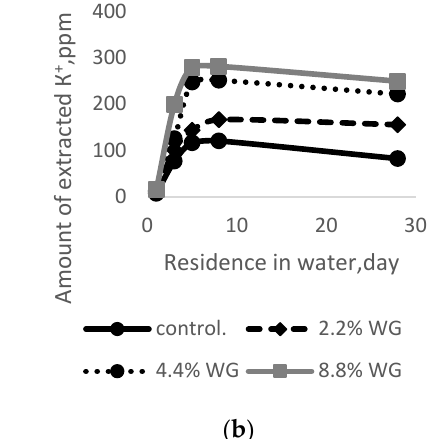
Figure 3. Dependence of the amount of extracted alkali cations on the addition of potassium WG and time in the water: ( a ) Na + ; ( b ) K + .